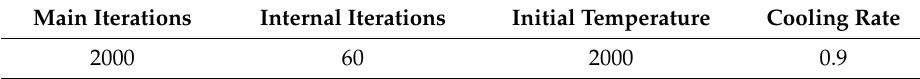
Table 2. Primary features of the simulated annealing (SA) algorithm.